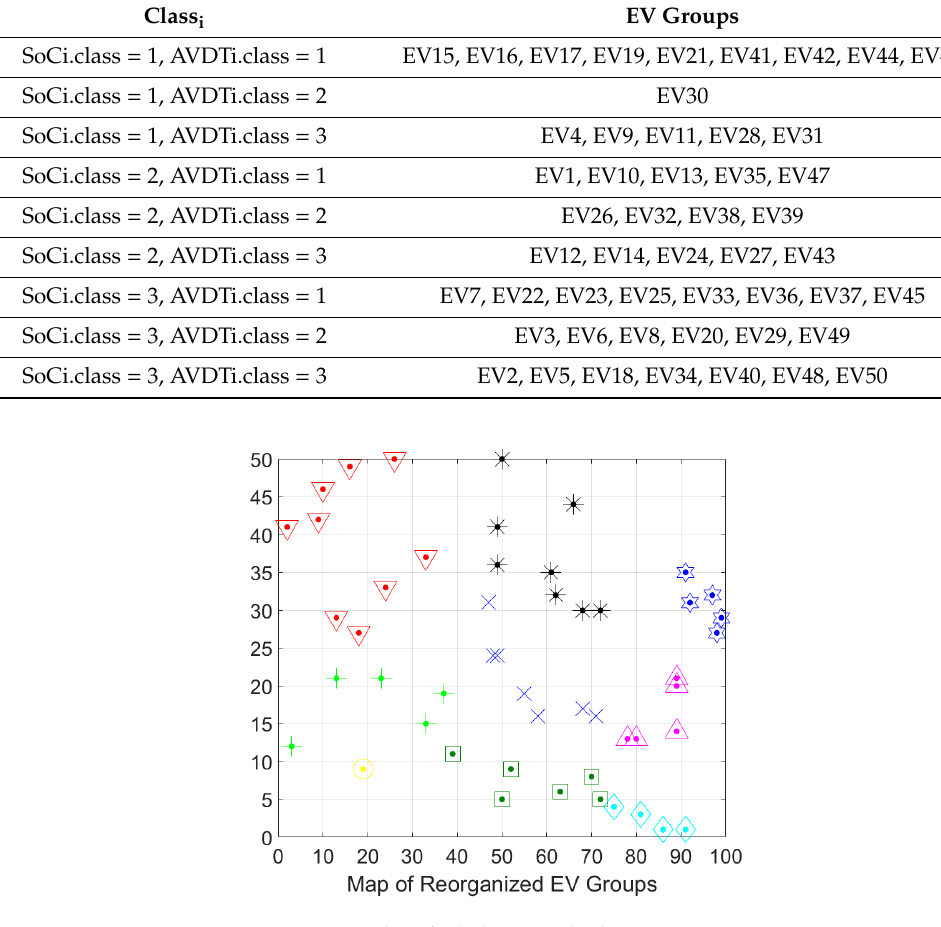
Figure 6. Auto-classified electric vehicle group map.